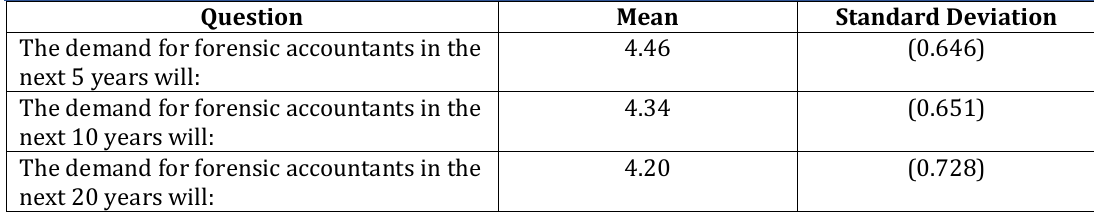
Table 16: Demand for Forensic Accountants in the Future Question Mean Standard Deviation